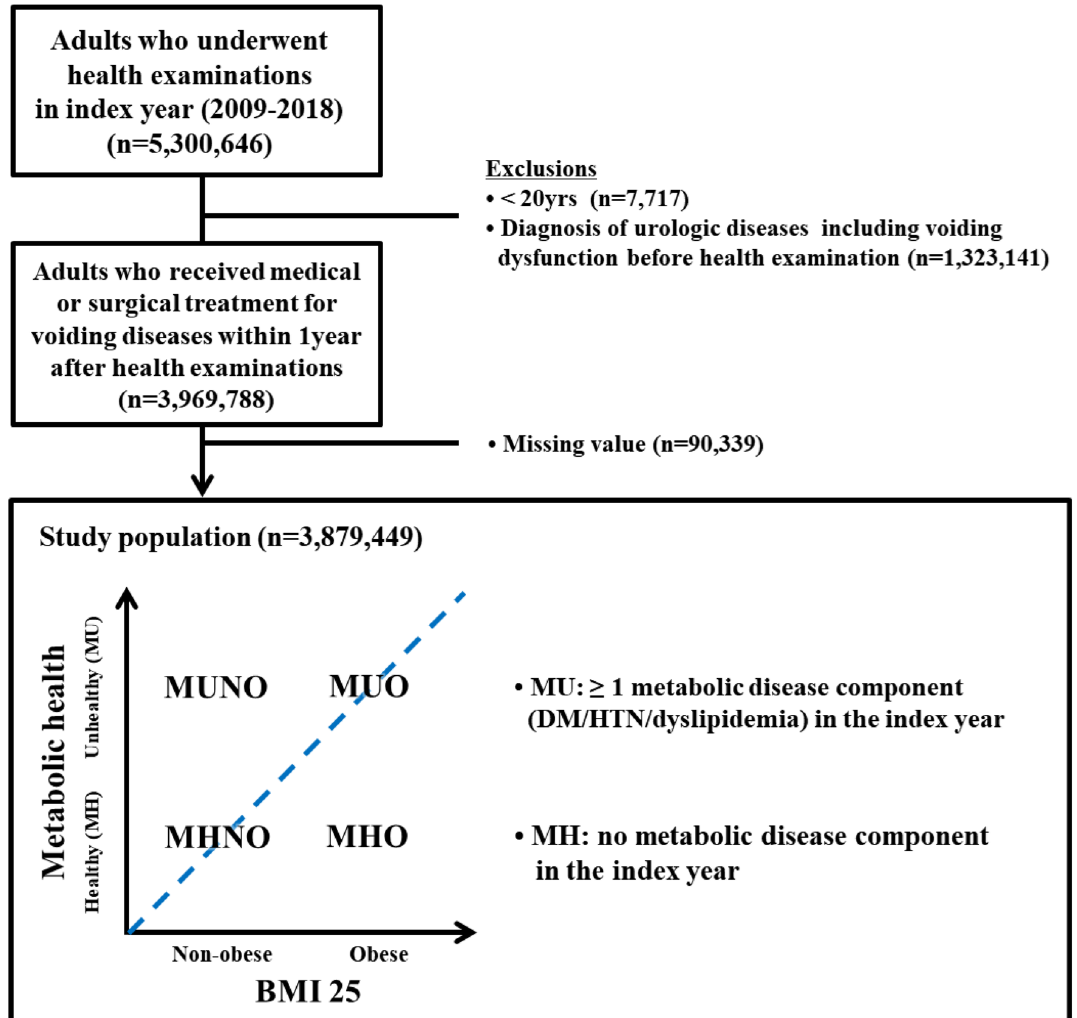
Figure 2. Flow diagram of study subjects. Of the 5,300,646 persons who received health examinations between 2009 and 2016, those aged < 20 years (n = 7,717) or those who were diagnosed with urologic diseases involving voiding dysfunction before the health examination (n = 1,323,141) were excluded. Within 1 year after the health examination, 3,969,788 patients were diagnosed with diseases related to voiding dysfunction and were treated medically or surgically. The final study population consisted of 3,879,449 subjects, except for 90,339 patients with missing